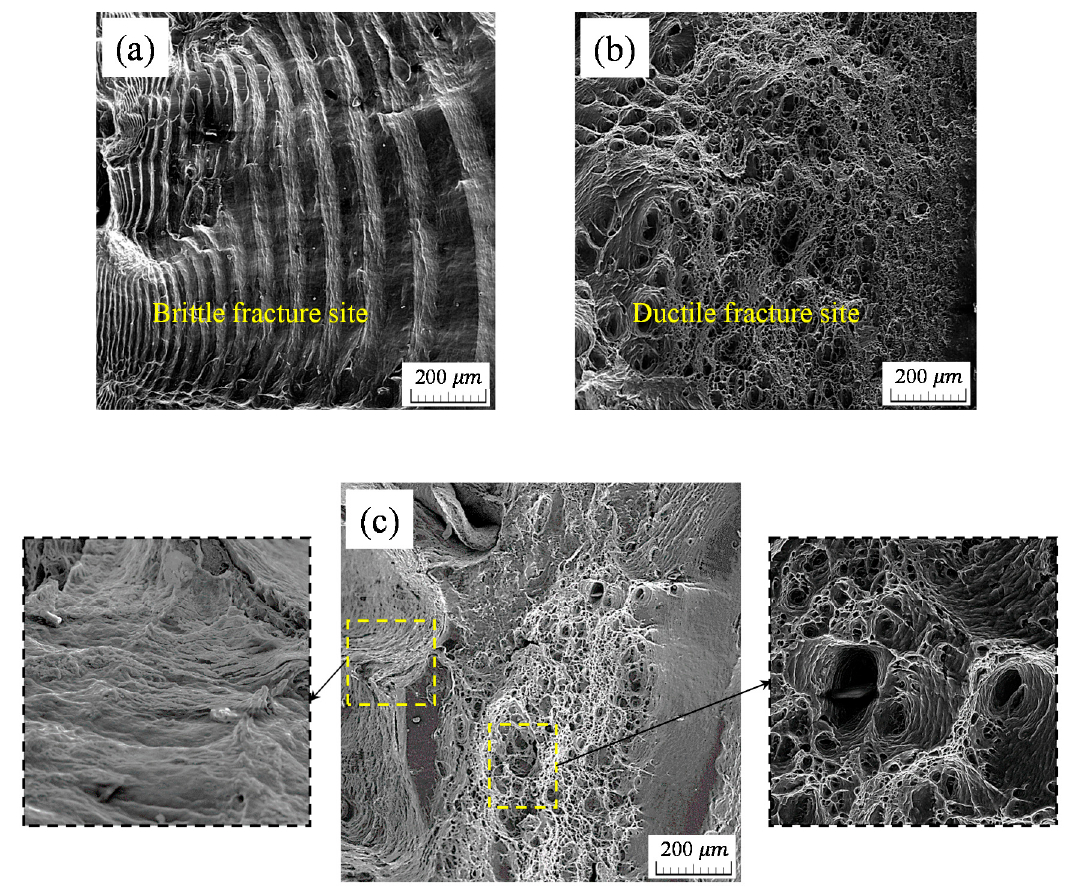
Figure 18. SEM images of fracture surface: ( a ) as-welded Al 1060-H16 FSW sample; ( b ) FSW sample with 100 μ m-thick copper foil in the SZ; ( c ) FSW sample with 200 µ m-thick copper foil in the SZ.